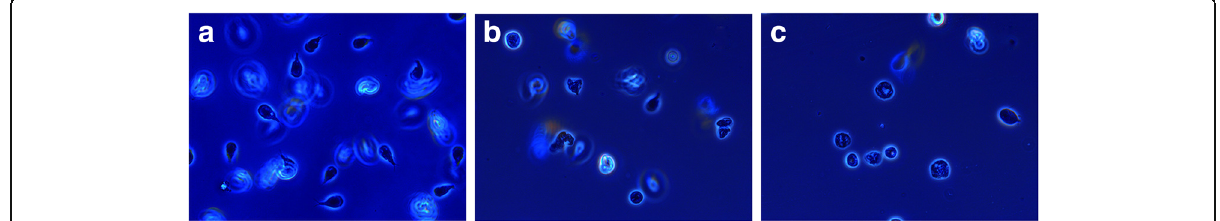
Fig. 5 Acivity of P. caribaeorum extract on Giardia intestinalis trophozoites. a Trophozoites without extract, ( b ) trophozoites exposed to 500 μ g/ mL, ( c ) Trophozoites with 1000 μ g/mL of